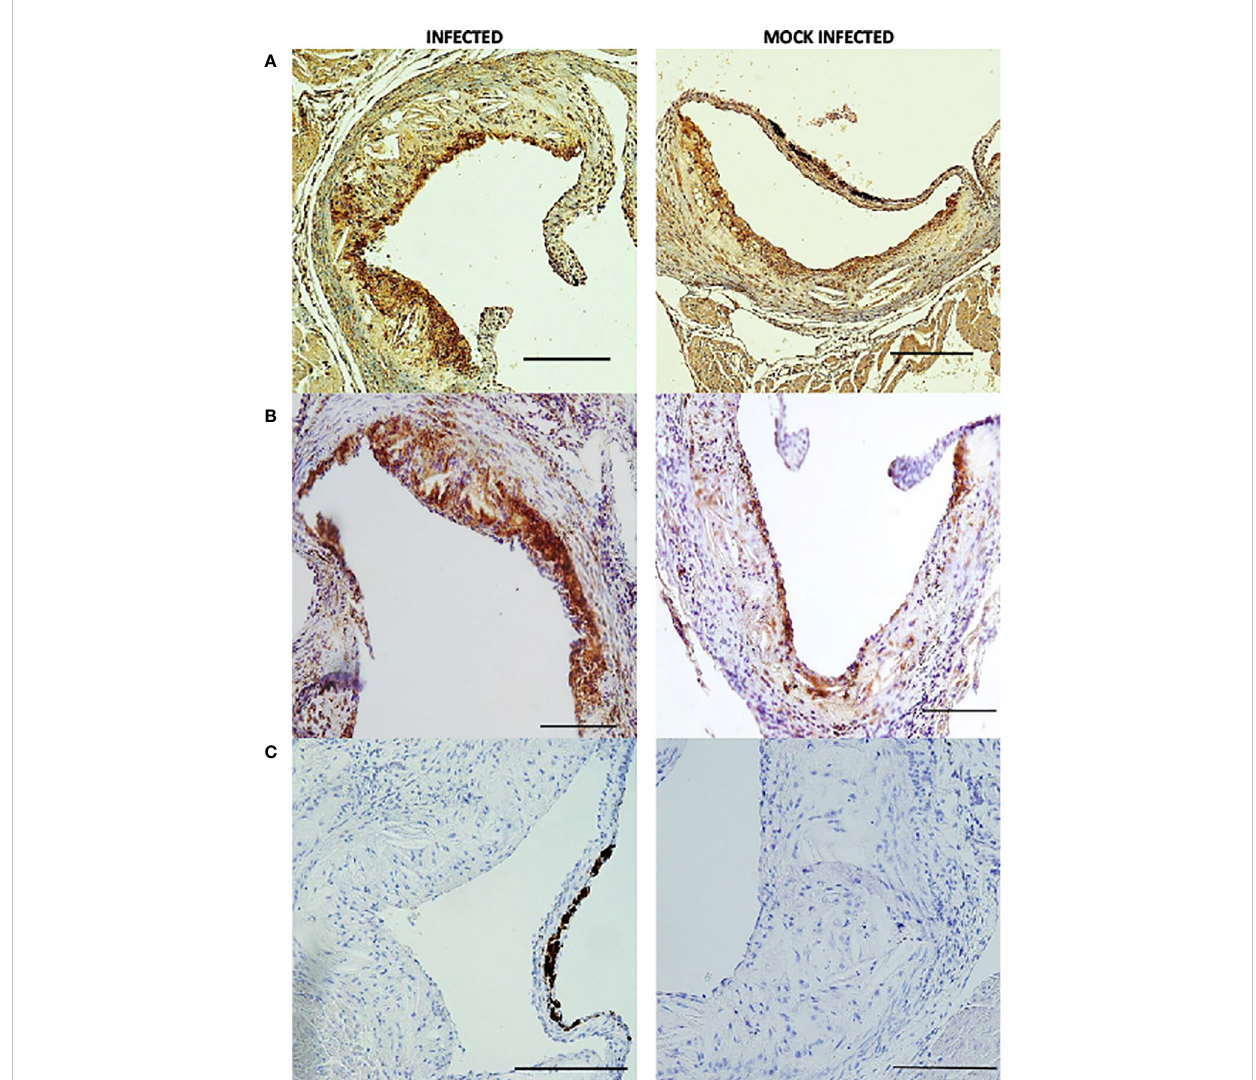
FIGURE 6 Individual aortic sinus atherosclerotic plaque sections 2 weeks post infection and mock infection. Representative images of MAC 3 (A, B) and haematoxylin and eosin (C) stained atherosclerotic plaque sections from S. pneumoniae infected (n=12) and PBS mock infected (n=11) ApoE -/- mice, using the optimised model as described in Figure 4. Scale bars represent 100